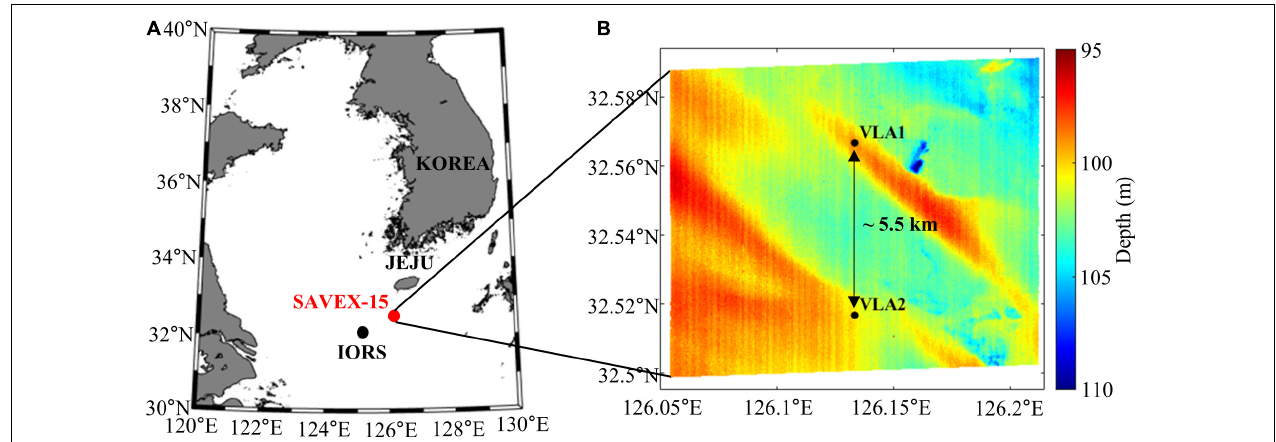
FIGURE 1 | (A) Location of the experimental site (red circle) of SAVEX-15. The black dot denotes the IEODO ocean research station (IORS). (B) Topographic map of the experimental site including two vertical line arrays (VLAs) separated by 5.5 km: VLA1 and VLA2.